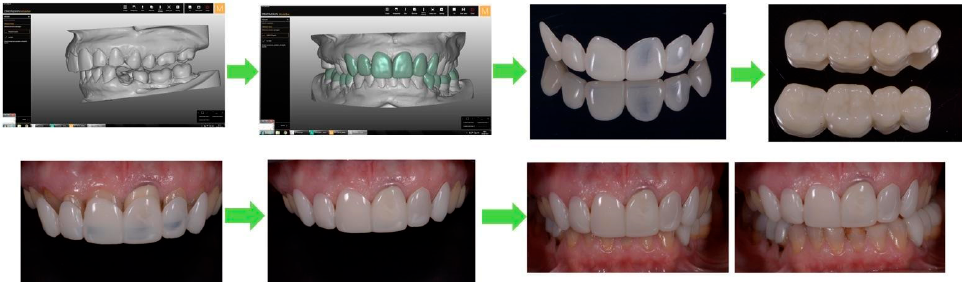
Figure 3. The images represent all the stages of the creation of the digital mockup, from design to insertion in the Figure 2. Occlusal, labial/facial and lingual views of the mockup obtained with a digital technique.